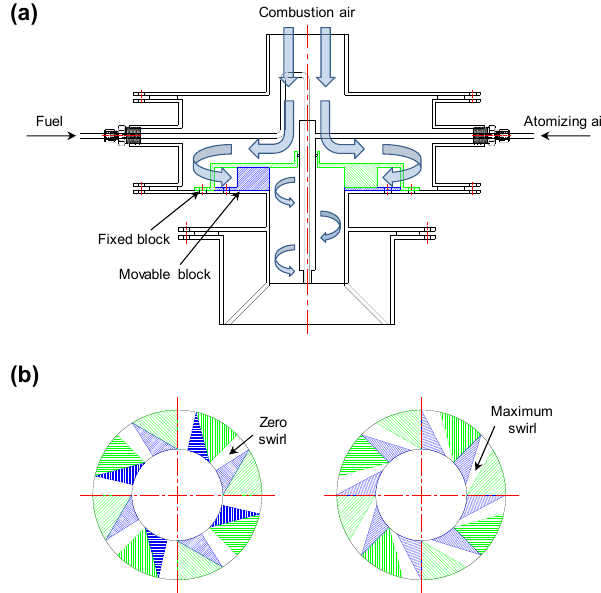
Figure 2. Schematic of burner unit ( a ) and movable block swirl generator ( b ).